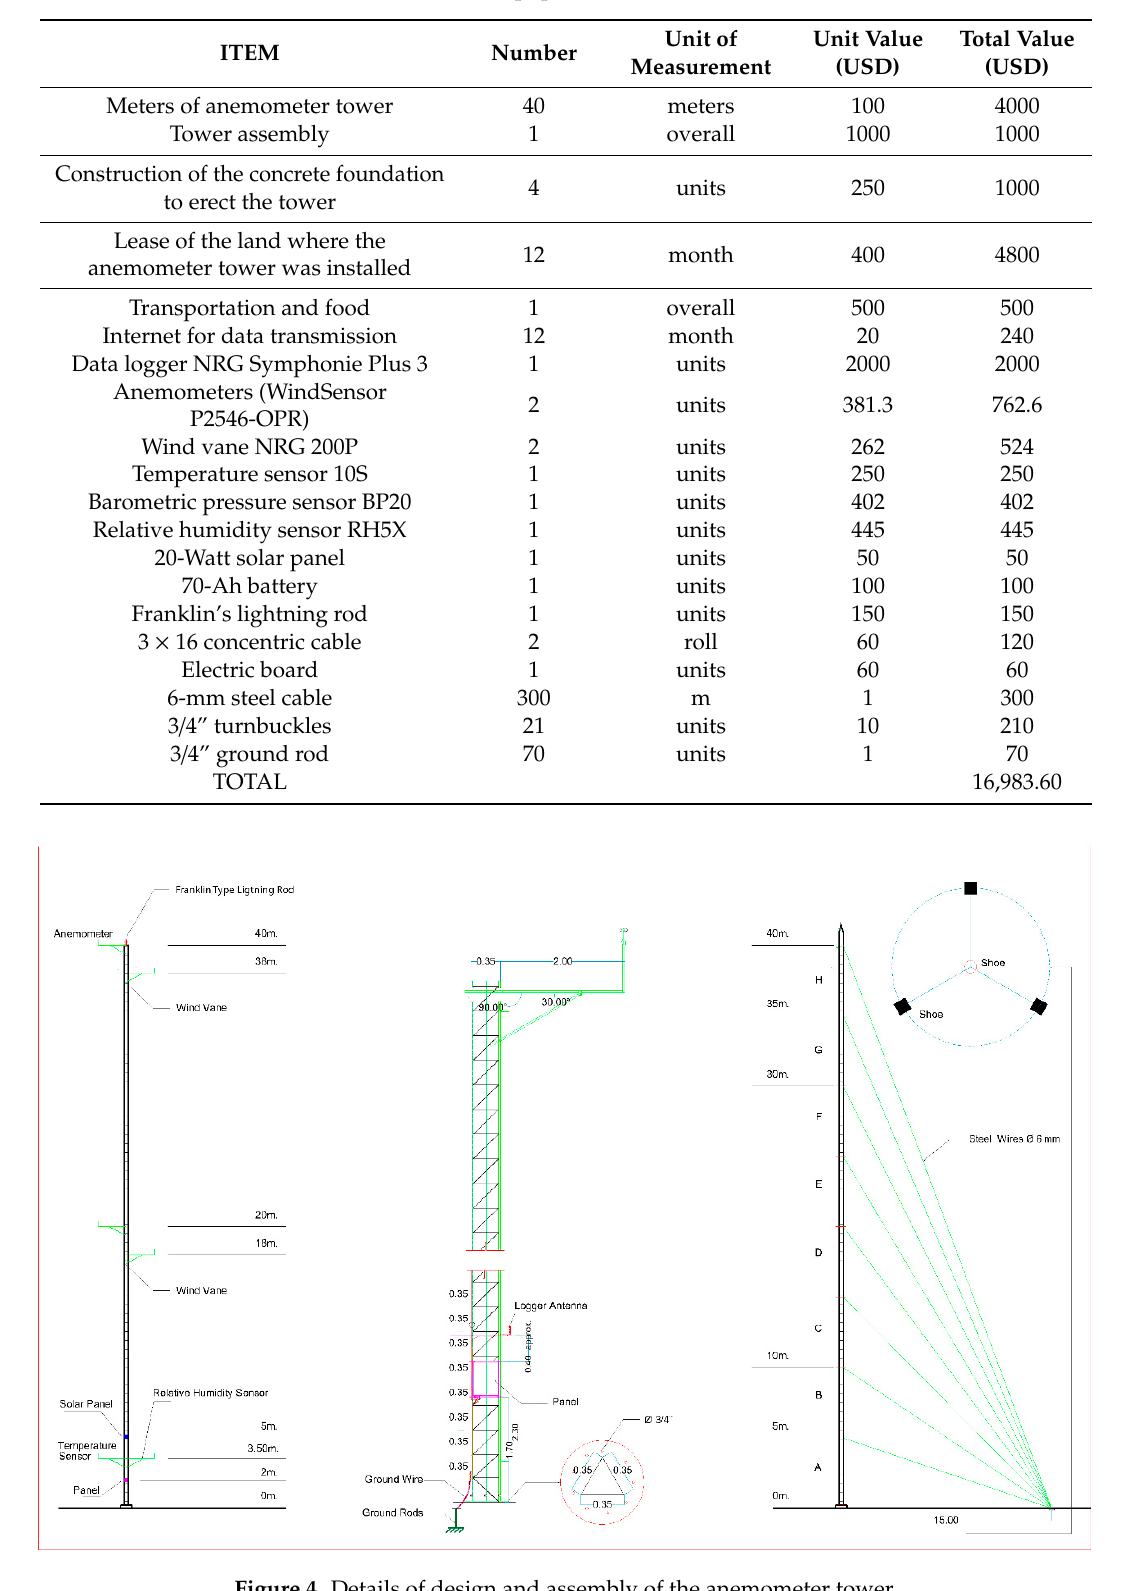
Table 2. Costs of equipment and materials used.